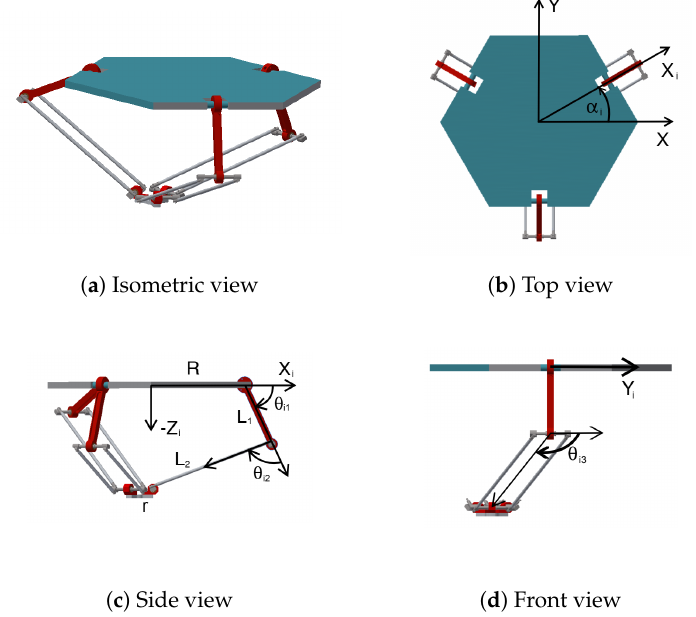
Figure 1. The PARALLIX LKF-2040, an academic Delta-type